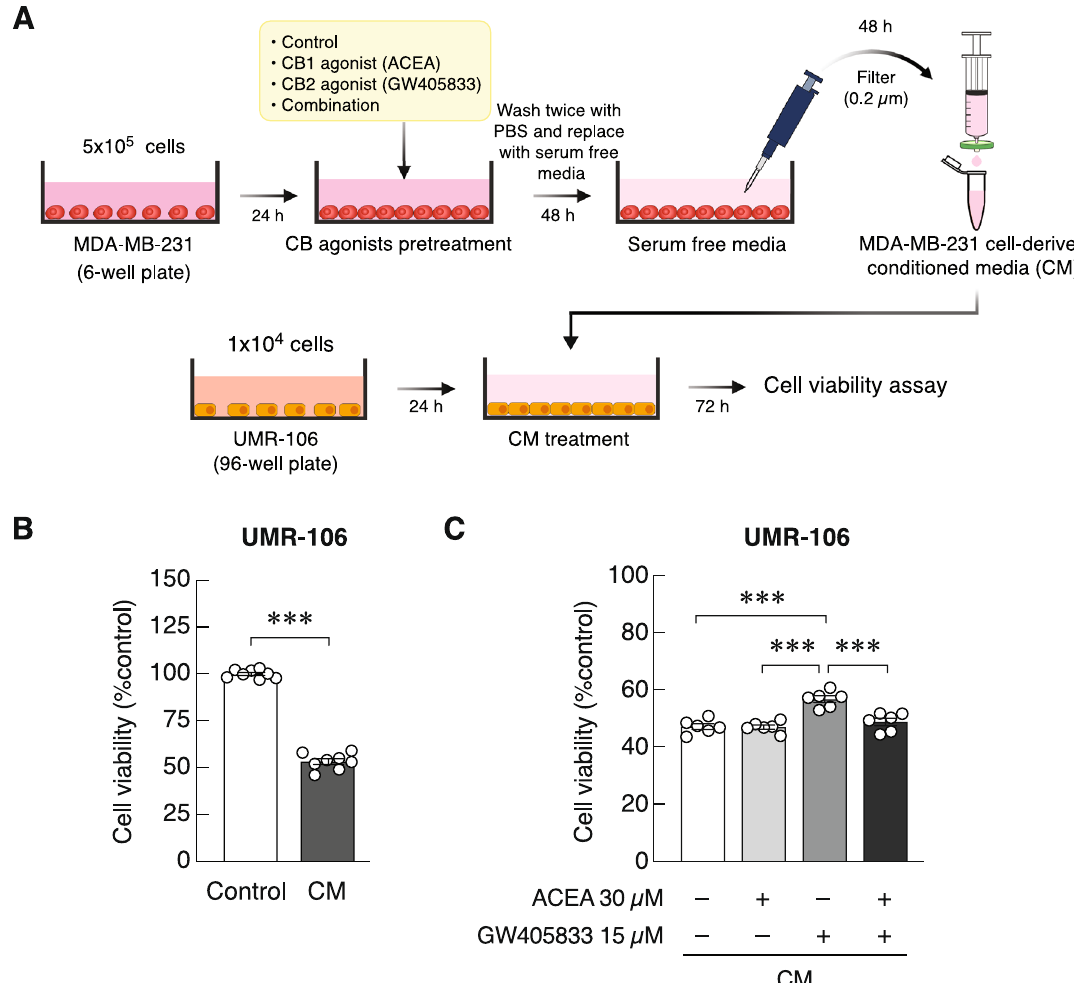
Figure 1. Effects of MDA-MB-231-derived CM and CM collected from MDA-MB-231 cells pretreated with ACEA, GW405833 or the combination of both on UMR-106 cell viability were illustrated. ( a )